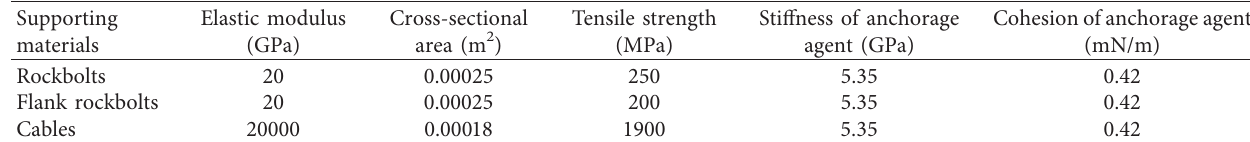
Figure 14: Improved support design of the recovery roadway in the #3-1 coal seam. Table 4: Mechanical parameters of the rockbolts and